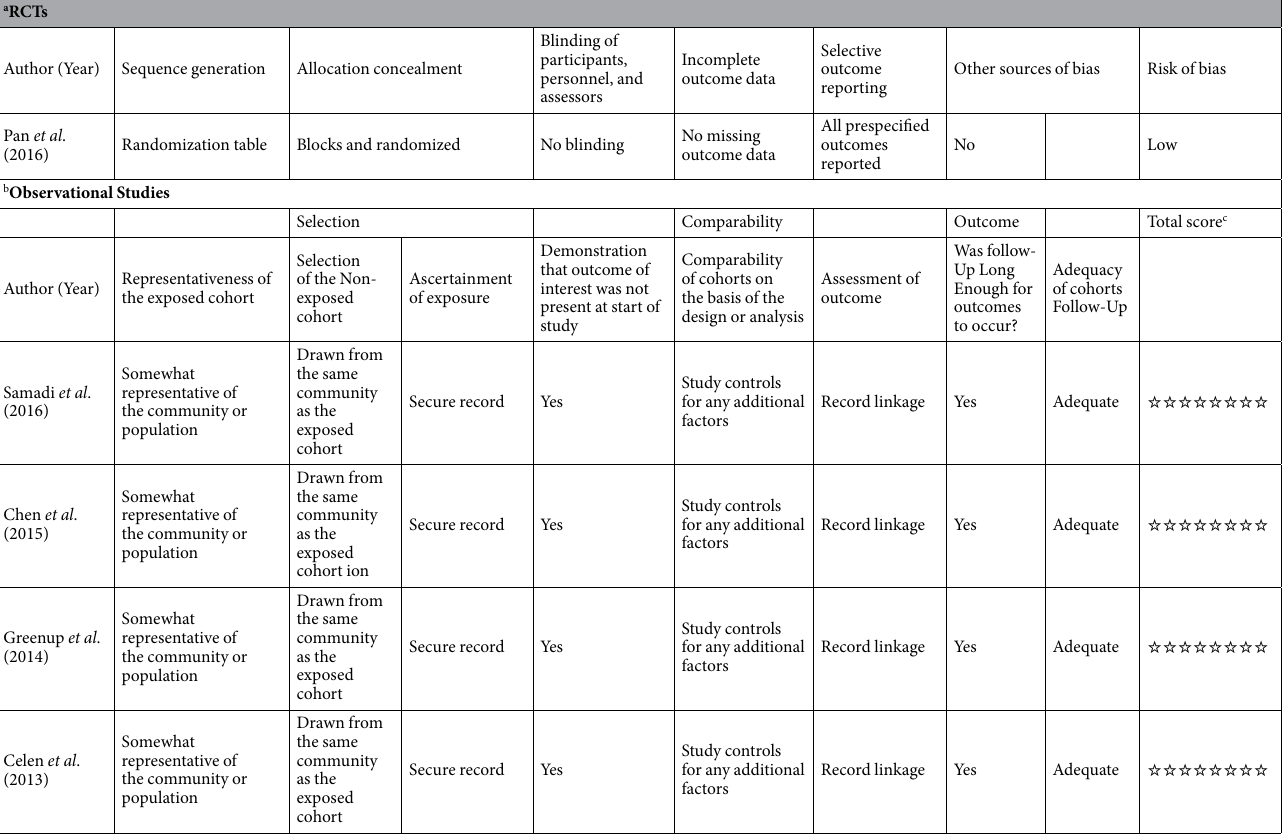
Table 3. Risk of bias assessment for the included studies. a For RCTs, risk of bias was assessed with Cochrane Risk of Bias assessment tool. b For observational studies, risk of bias was assessed with the Newcastle-Ottawa Scale. c Calculated by adding the points awarded for each item.